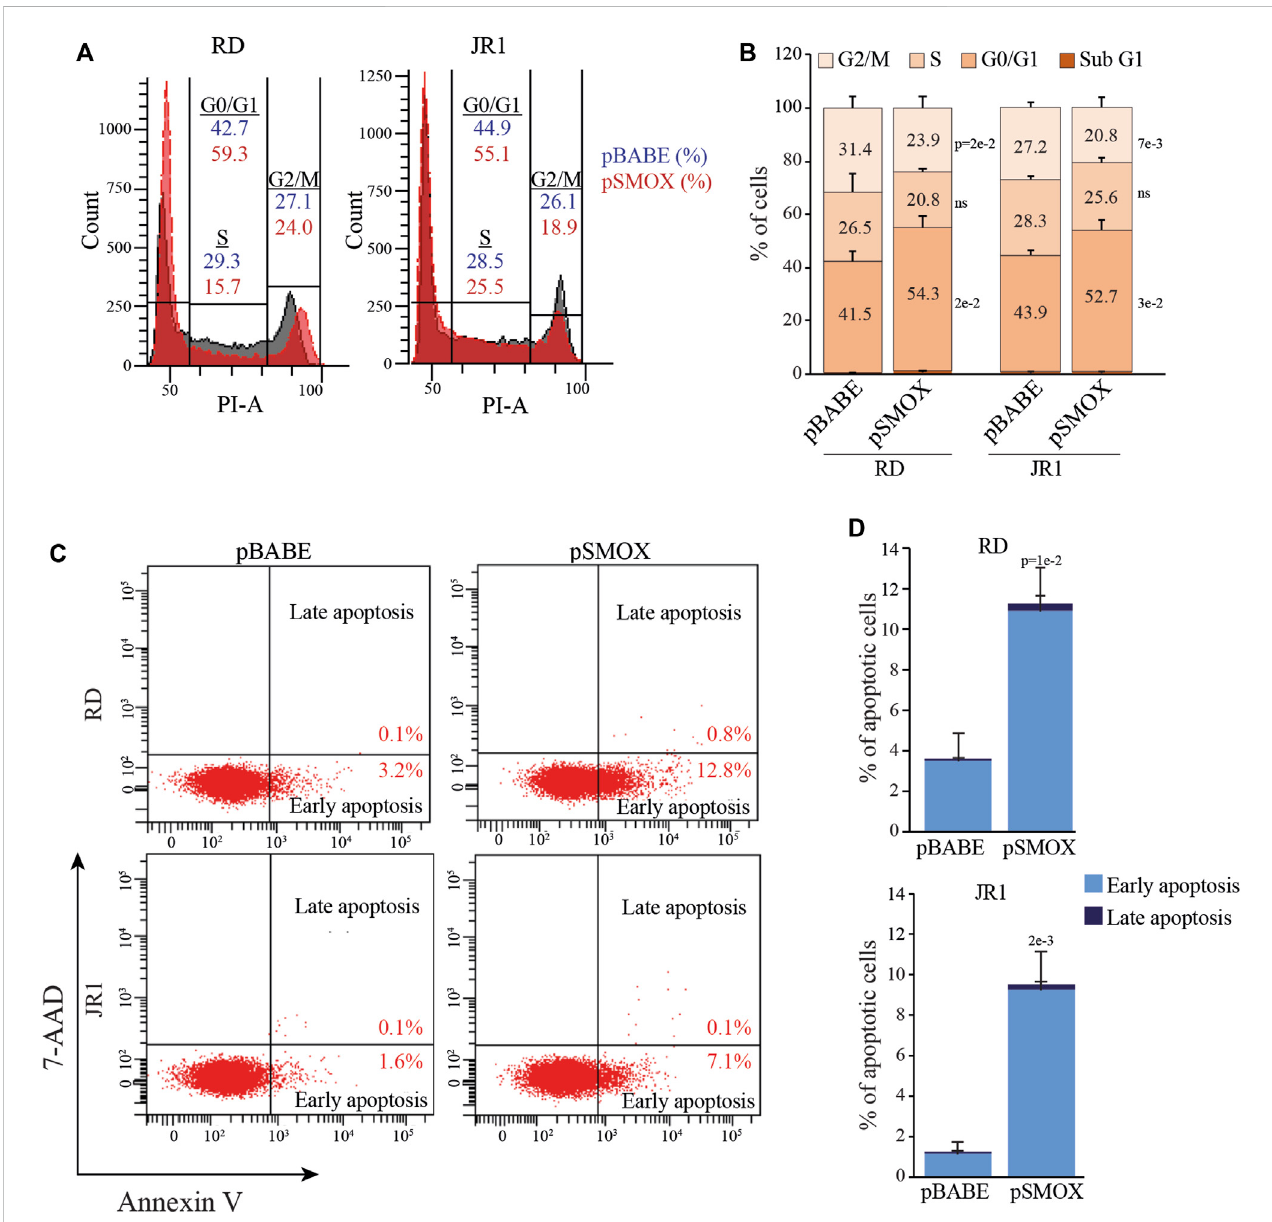
FIGURE 3 SMOX overexpression in FN-RMS cell lines induces G0/G1 cell cycle arrest and apoptosis. (A) Representative diagrams of fl ow cytometry analysis of PropidiumIodide(PI)stainedRDandJR1transducedwithpBABEandpSMOXandanalyzed24 hposttransduction. (B) Histogramdepicting thepercentageof SMOX overexpressing-RD and -JR1 cells in subG1, G0/G1, S, and G2/M phases. Graph represents the mean of three independent experiments ±SD, Student two-tailed t -Test. Exact p -values are reported in the fi gure. (C) Representative cyto fl uorimetric plots of Annexin V/7-AAD ( n = 3 independent biological replicates)ofRDandJR1transducedwitheitherpBABEorpSMOXandanalyzed48 hposttransduction. (D) HistogramdepictingthepercentageofAnnexin-V positive/7-AAD single- and double-positive RD and JR1 cells. Graphs represent the mean of three independent experiments ±SD, Student two-tailed t -Test. Exact p -values are reported in the fi